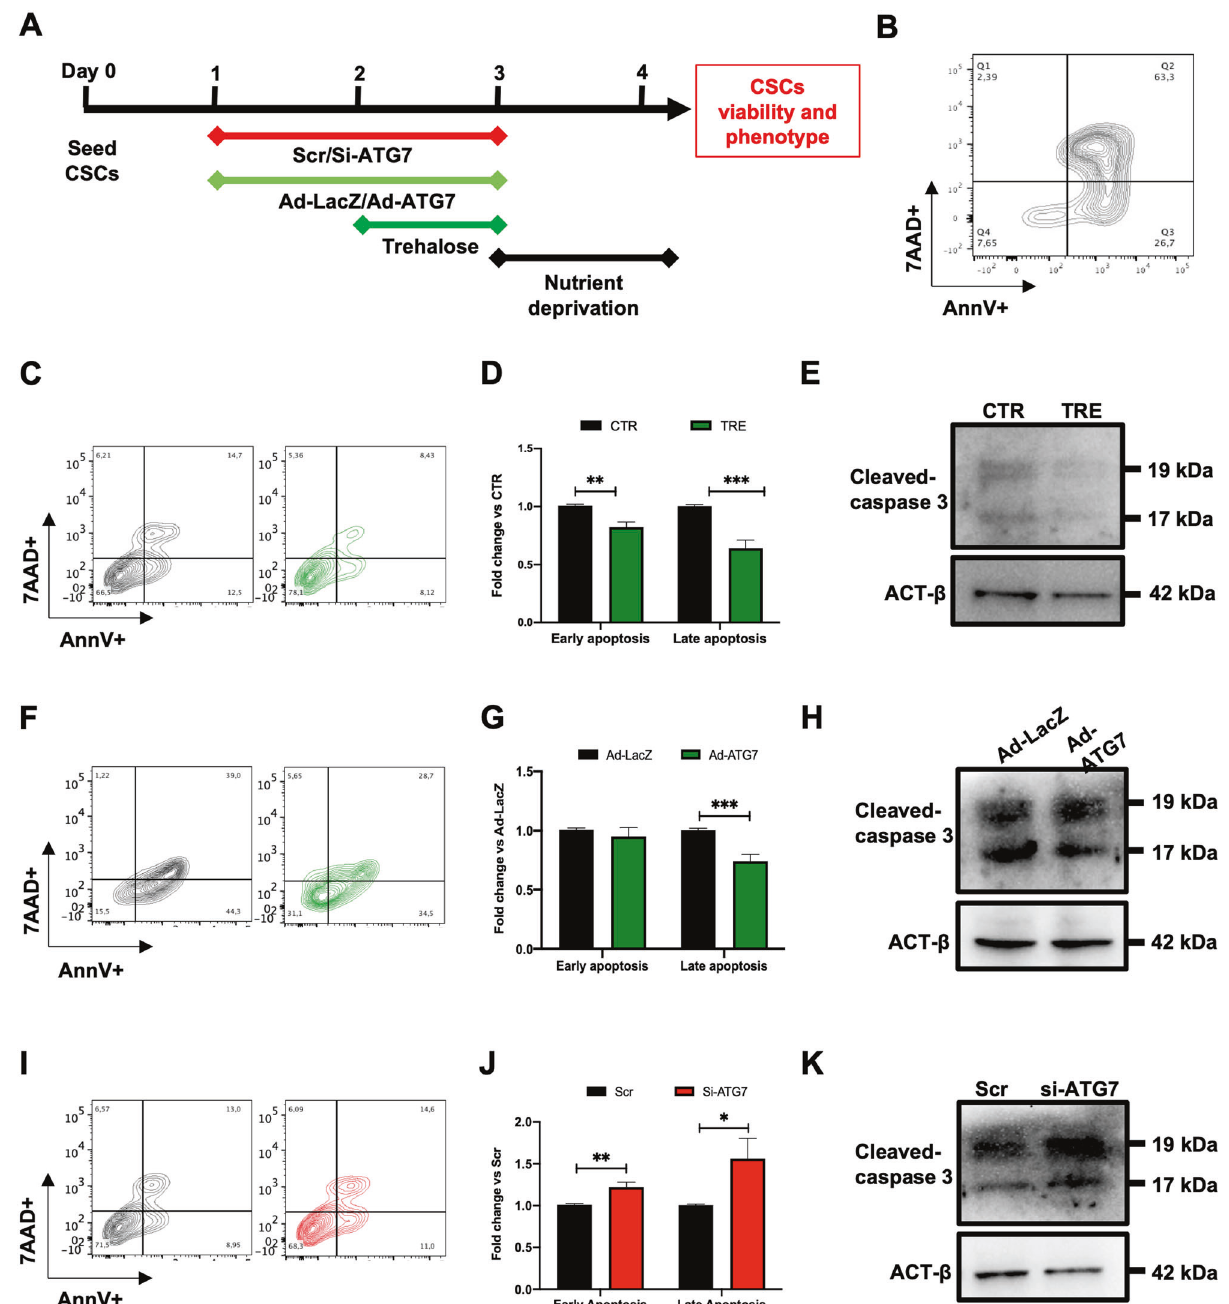
Fig. 3 Autophagy stimulation reduces apoptosis in starved CSCs. A Experimental timeline and design for autophagy modulation and cell viability assessment. B Representative contour plot of the positive control of apoptotic induction. Representative fl ow cytometry density plots (C) and relative quanti fi cation (D) of early (Annexin-V + /7AAD-) and late (Annexin-V + /7AAD + ) apoptotic CSCs after 32 hours of nutrient deprivation (0.1% FBS, 0 mM glucose), with or without pretreatment with 50 mM trehalose (TRE) for 24 hours ( n = 8); corresponding WB panel for cleaved caspase 3 is shown in paneI (E) . Representative fl ow cytometry density plots (F) and relative quanti fi cation (G) of early and late apoptotic cells after 32 hours of nutrient deprivation in CSCs that were previously transduced with ad-ATG7 or ad-LacZ 48 hours before stress ( n = 7); corresponding WB panel for cleaved caspase 3 is shown in panel (H) . Representative fl ow cytometry density plots (I) and relative quanti fi cation (J) of early and late apoptosis after 32 hours of nutrient deprivation in CSCs that were pre-treated with si-ATG7 or scramble control (Scr) transfection 48 hours before stress ( n = 7); corresponding WB panel for cleaved caspase 3 is shown in panel (K) . * P <0.05, ** P <0.01, *** P viability, suggest that TRE may be more effective than ad-ATG7 in activating autophagy in CSCs under our conditions, albeit a direct subpopulation) was signi fi cantly reduced after nutrient deprivation comparison is not feasible given the different nature of the two stress in TRE-treated CSCs, as compared to controls (Fig. 4C, D). stimuli. These results, together with the above-mentioned outcome on cell